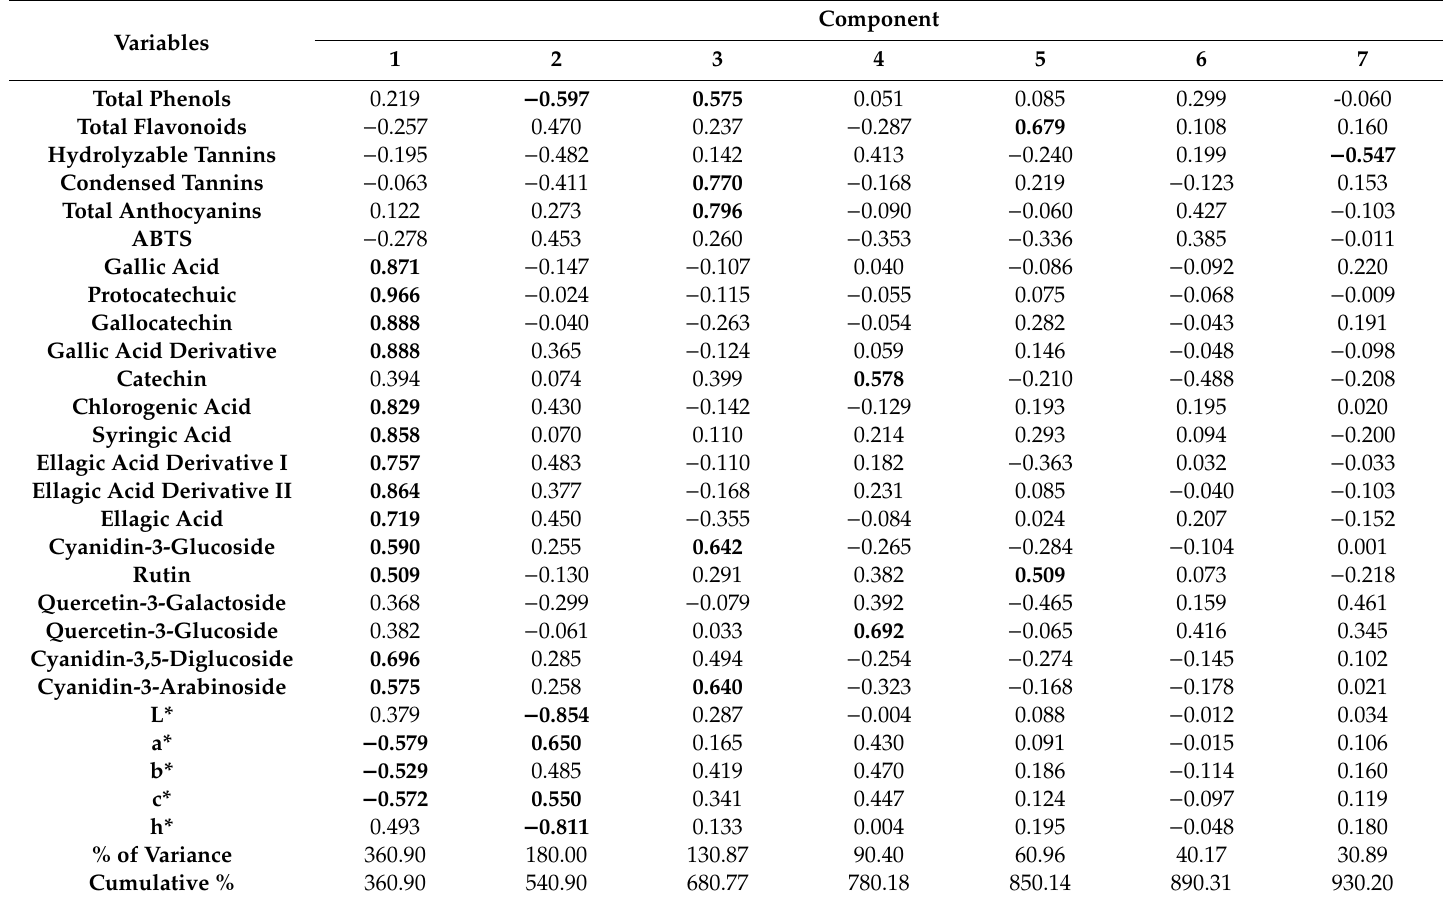
Table 7. Eigenvectors of principal component axes from PCA analysis of studied